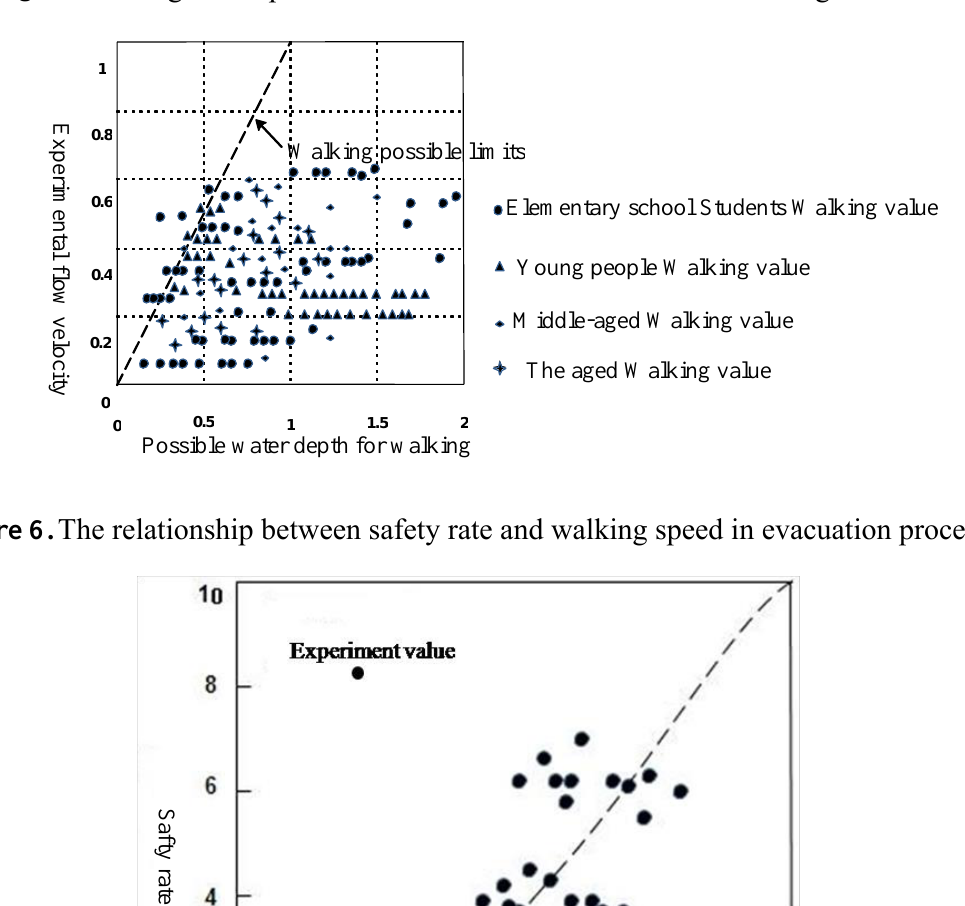
Figure 5. The greatest possible threshold limits for residents’ walking in water.